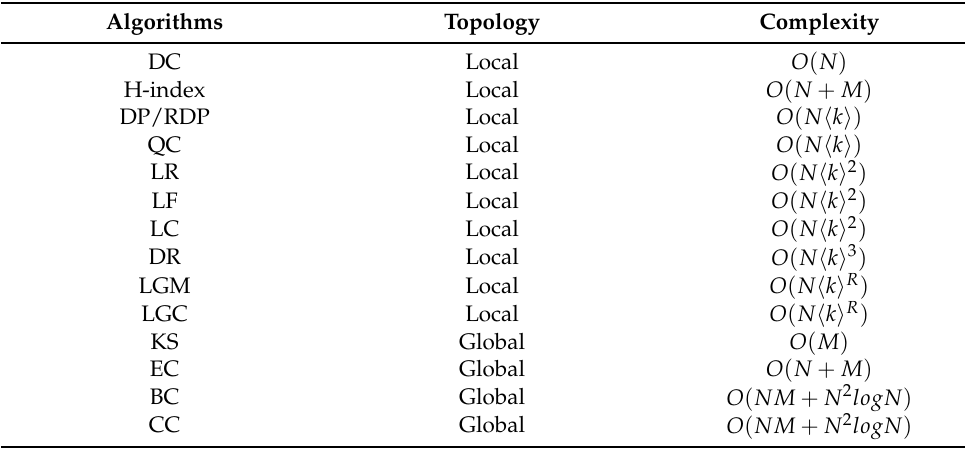
Table 3. The computational complexity of different